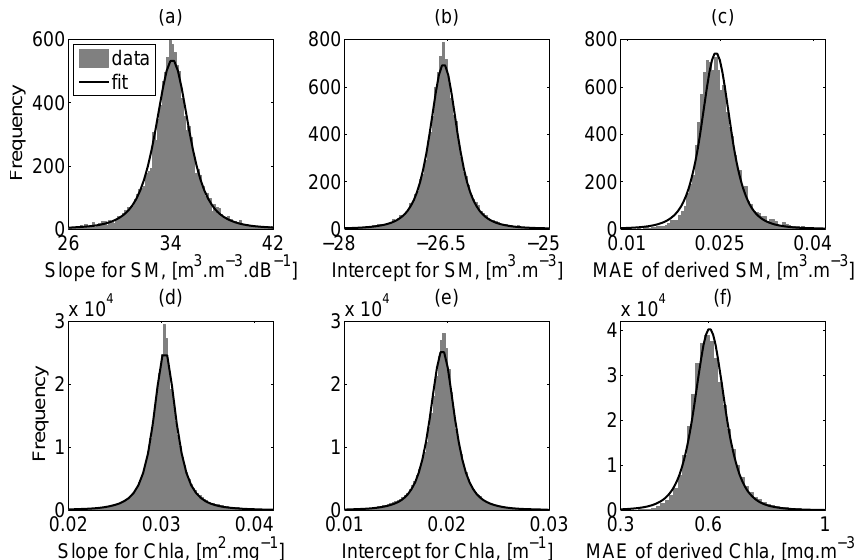
Fig. 2. Derived probability distributions of model coefficients (a, b, d, e) and associated uncertainties (c, f) for the OPE 3 data (upper panels) and NOMAD matchups (lower panels). The solid lines are the fits by Eq. (5) with coefficients given in Table